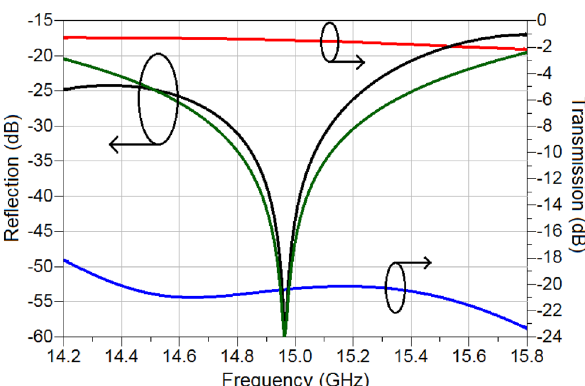
Figure 22. Performance of RTVA of figure, based on extracted values of TiO 2 ; black—reflection coefficient in the OFF state, green—reflection coefficient in the ON state, red—insertion loss in the OFF state and blue— insertion loss in the ON